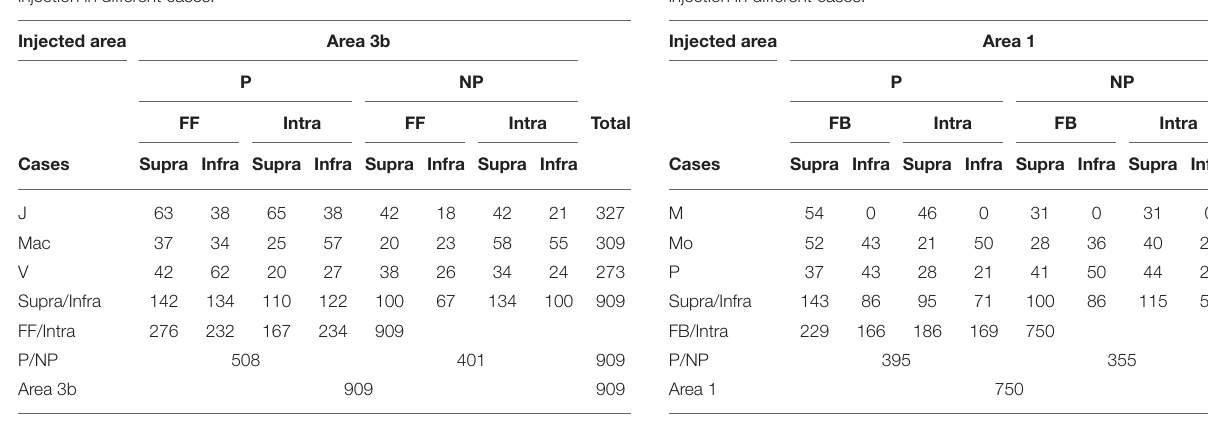
TABLE 4 | The number of boutons in different pathways labeled by area 1 injection in different